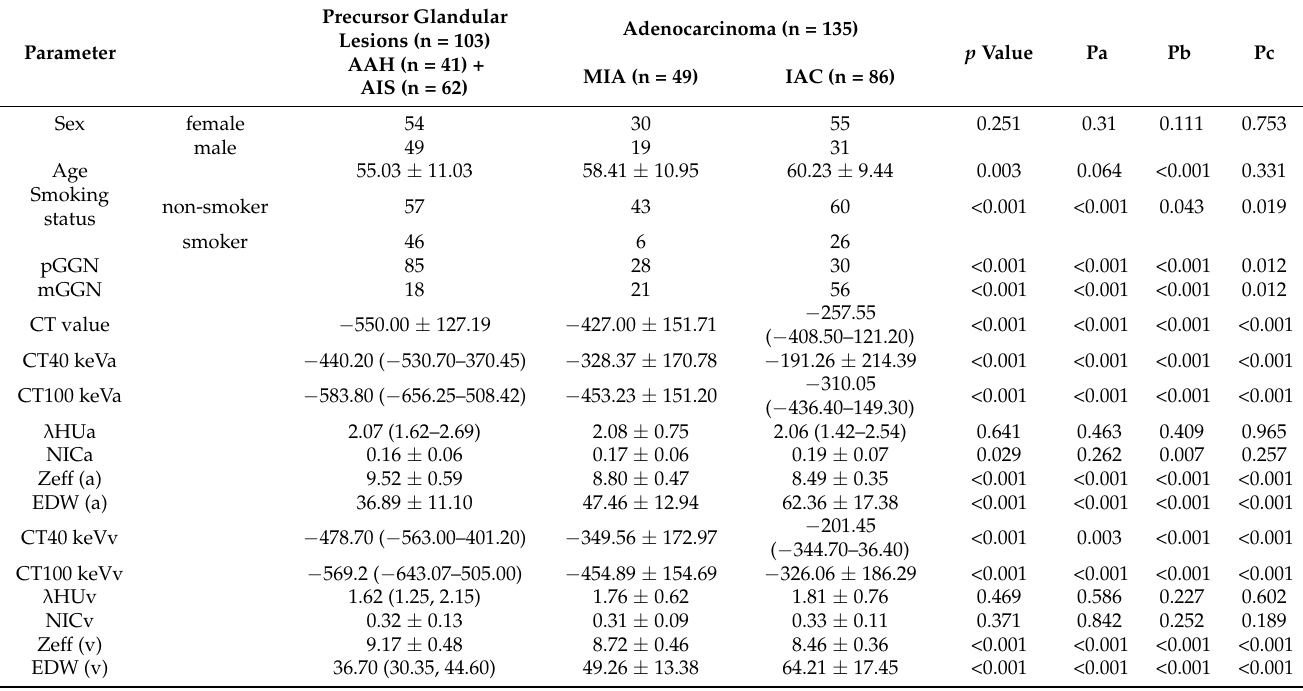
Table 2. Comparison between the quantitative parameters of GGN-featured lung adenocarcinoma of precursor glandular lesions and